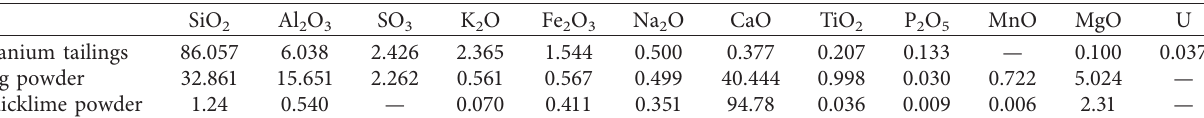
Figure 1: Main test materials. (a) Uranium tailings, (b) water-quenched slag powder, (c) quicklime powder, (d) liquid sodium silicate, and (e) sodium hydroxide. Table 1: Main chemical composition of test materials (%).